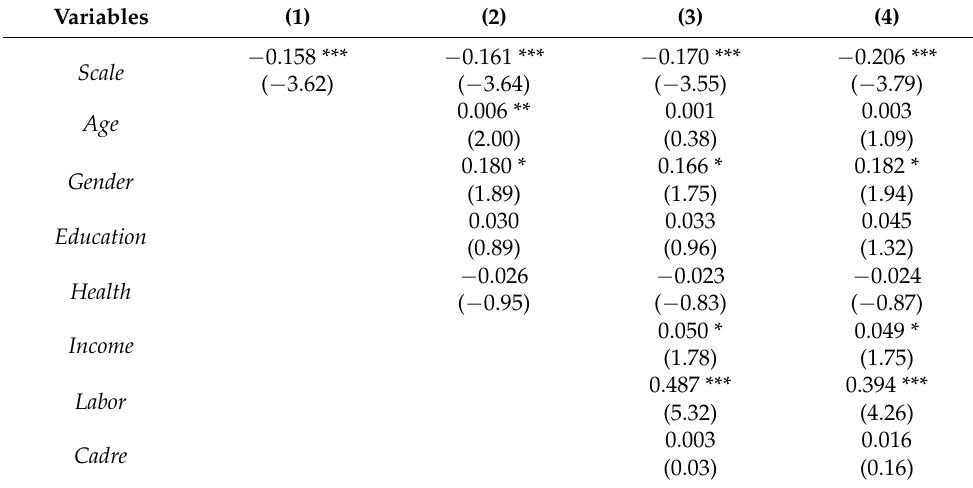
Table 1. The effect of the scale of cultivated land management on the amount of fertilizer applied per